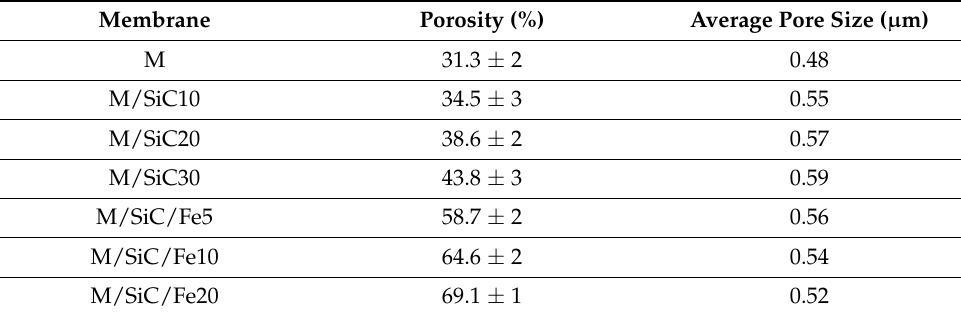
Table 6. Porosity and the average pore size of MF membranes.